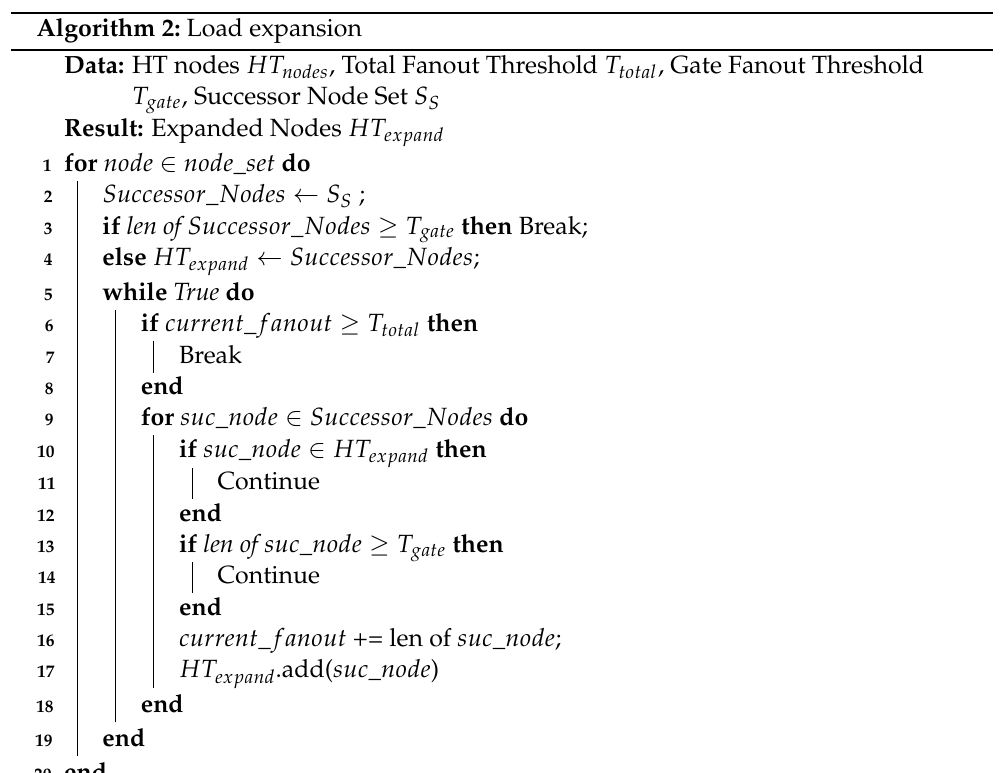
Algorithm 2: Load expansion